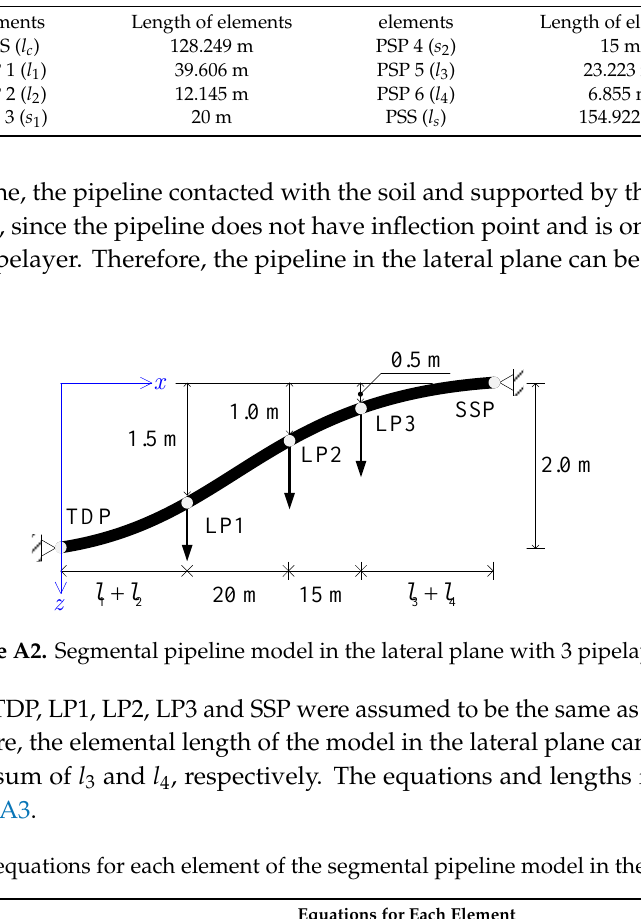
Table A3. The equations for each element of the segmental pipeline model in the lateral plane Equations for each element Elemental length